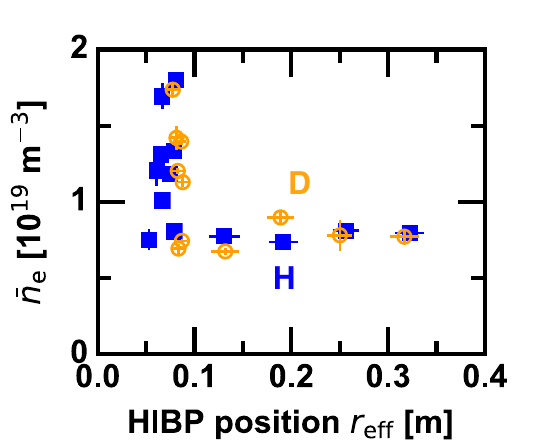
Figure 4. Parameter map of line averaged density and HIBP position on which discharges were performed by a shot-to-shot